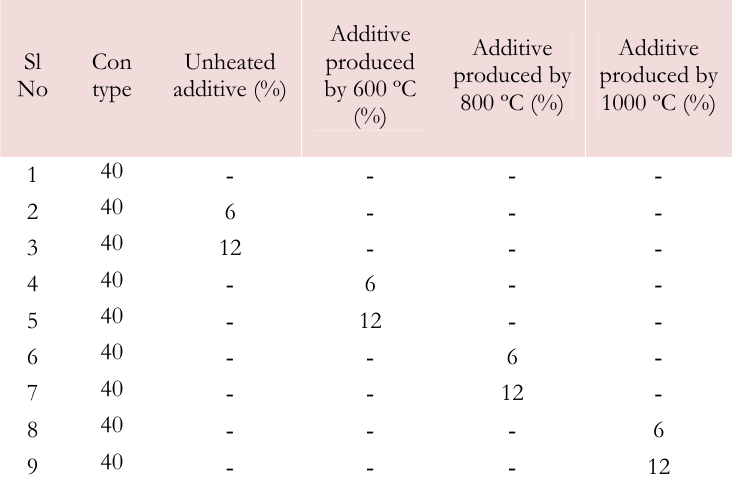
Table 1: Concrete-additive mixture ratio.